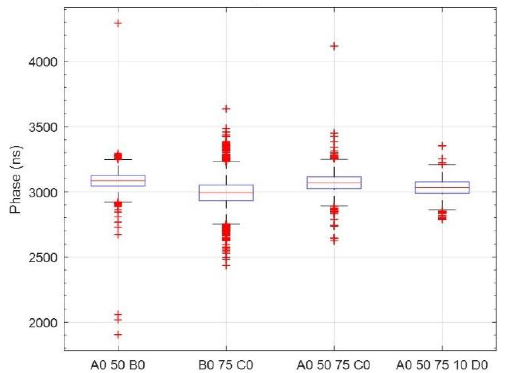
Figure 19. Box diagram with two